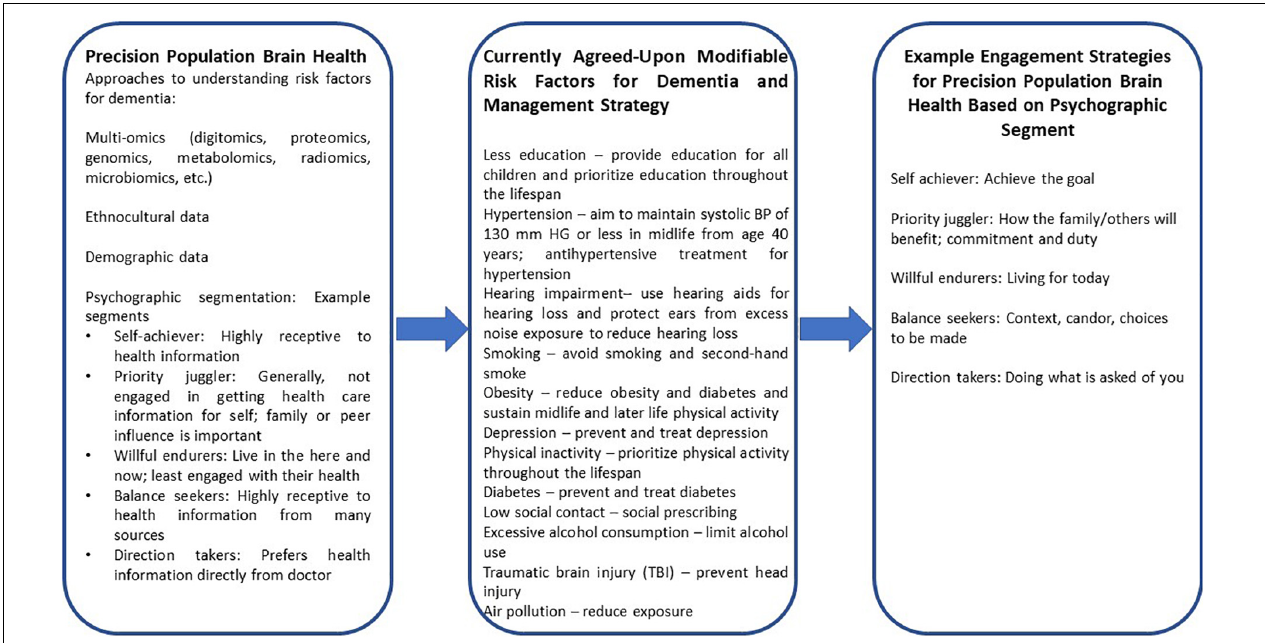
FIGURE 1 | Examples of how psychographic segmentation can enable a Precision Population Brain Health approach to care through addressing modifiable risk factors of dementia and enhancing patient engagement.